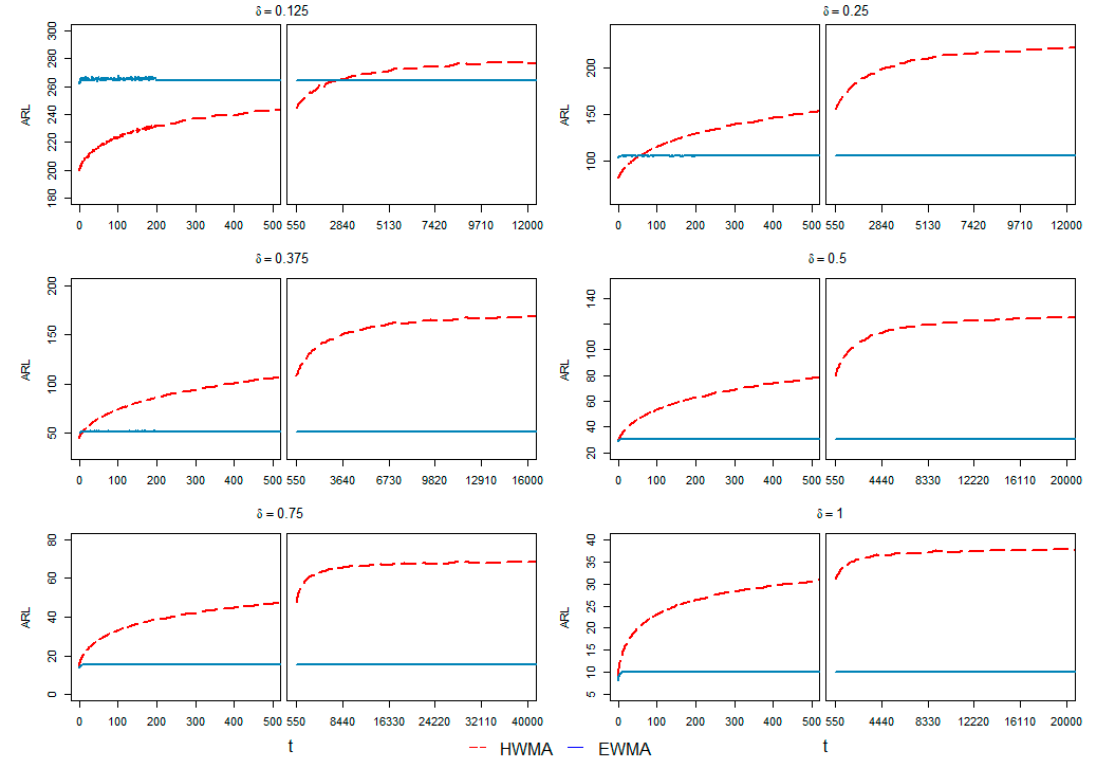
Figure 6. CED curves for the HWMA and EWMA charts under small to moderate shifts at 𝜆 = 0.1 with respect to time points (𝑡) .